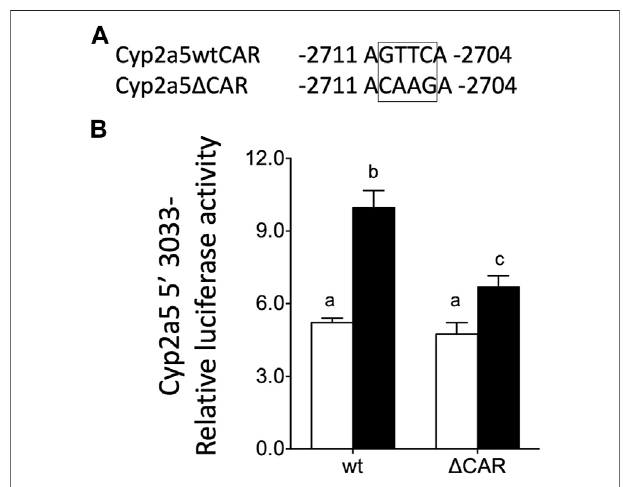
FIGURE9| MurineCARoverexpression increasesCyp2a5transcription via a CAR response element in the murine Cyp2a5 promoter region. (A) The sequence of a CAR response element within the Cyp2a5 promoter region showingsite-directedmutation. (B) Cyp2a5-5 ′ -3,033luciferasereporter activities were assessed in primary mouse hepatocytes co-transfected with a CAR expression plasmid (black bars) or without co-transfection (white bars). In addition, the effect of site-directed mutation of the CAR response element ( Δ CAR) on Cyp2a5 transcriptional activation of Cyp2a5 was tested. The measured activities were normalized against Renilla (pRL-TK) activities. All values represent the mean ± SEM (n (cid:2) 4 hepatocyte cultures from different mice). Bars with different letters are signi fi cantly different ( p ≤ 0.05).